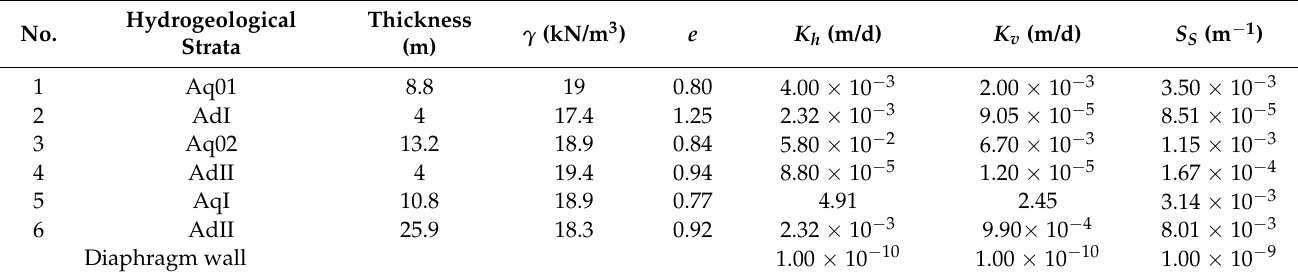
Table 2. Parameters used in numerical